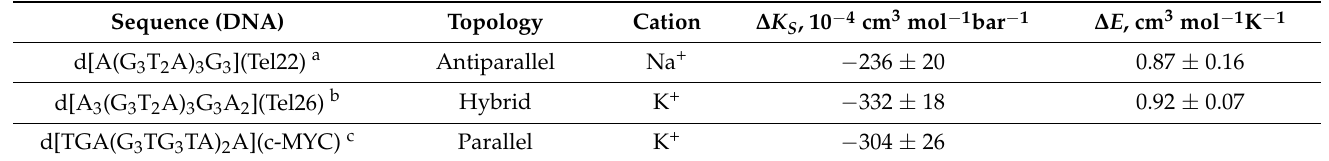
Table 6. Changes in adiabatic compressibility, ∆ K S , and expansibility, ∆ E , accompanying the unfolding transitions of G-quadruplexes varying in sequence, topology, and stabilizing cation at 25 ◦ C. Sequence